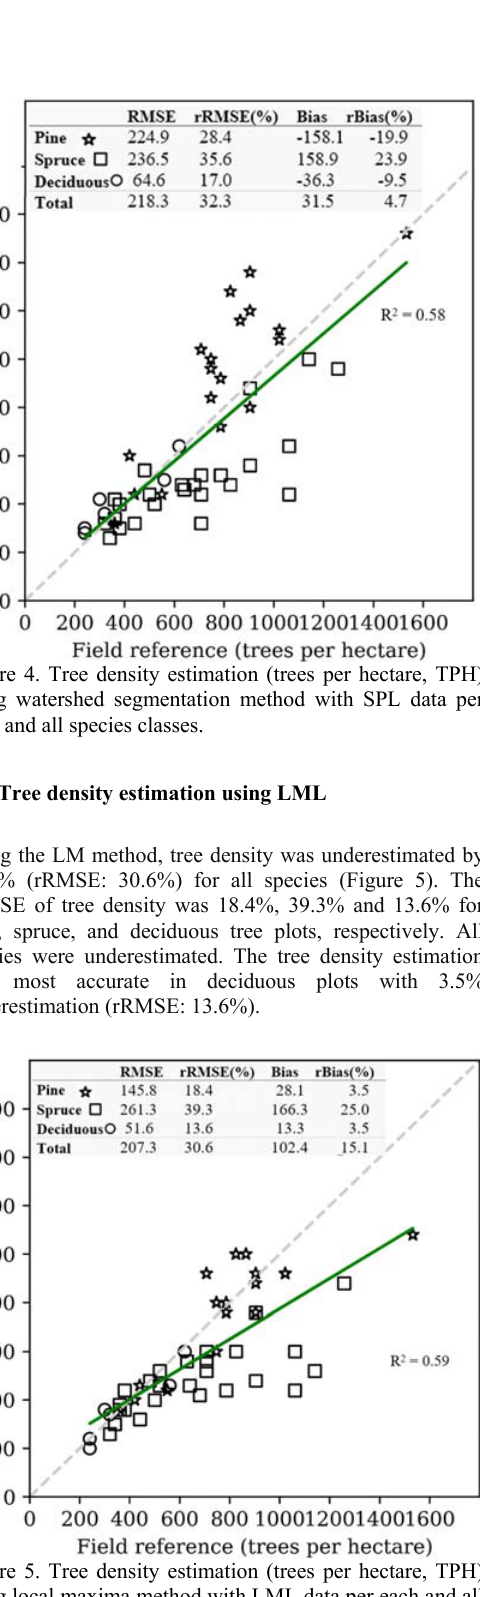
Figure 5. Tree density estimation (trees per hectare, TPH) using local maxima method with LML data per each and all species